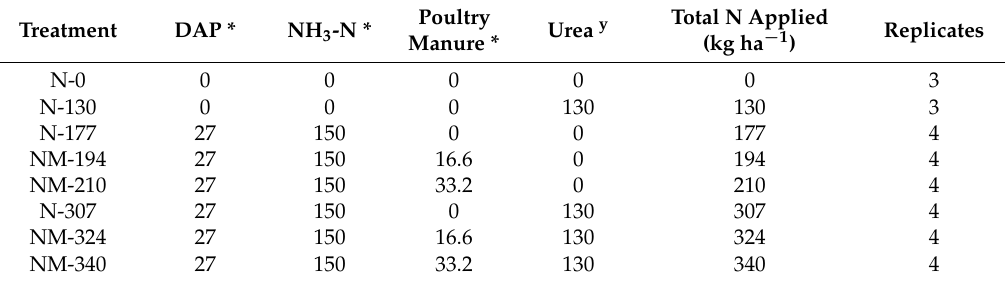
Table 1. Total nitrogen (N) applied to each treatment and contribution and date of application of the four fertilizer products used in the study: poultry manure, diammonium phosphate (DAP), anhydrous ammonia (NH 3 -N) and urea. The number of replicates used for each treatment is also indicated. Poultry Total N Applied Treatment DAP * NH 3 -N * Urea y Manure * (kg ha − 1 )